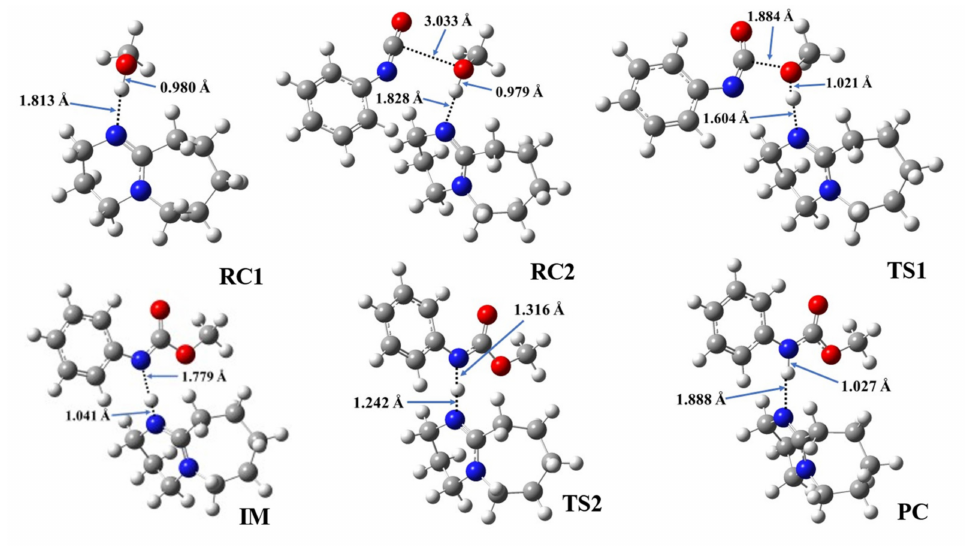
Figure 4. Optimized structures along the reaction pathway between phenyl isocyanate and methanol in the presence of catalyst 1, calculated at the BHandHLYP/6-31G(d) level of theory in acetoni- trile at 298.15 K and 1 atm. RC—reactant complex, TS—transition state, IM—intermediate, and PC—product